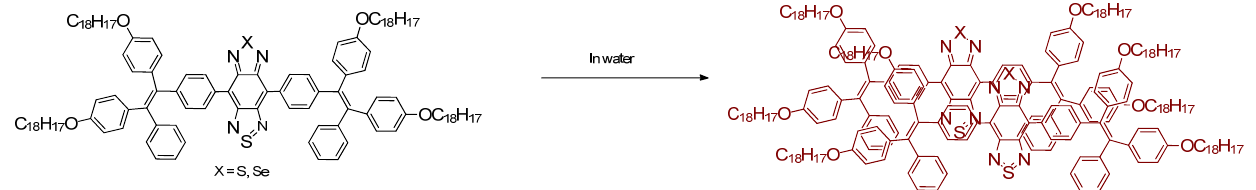
Figure 10. The compound and its aggregation tendency in water was described by Wu et al. The position of the selenium is specific and is discussed.